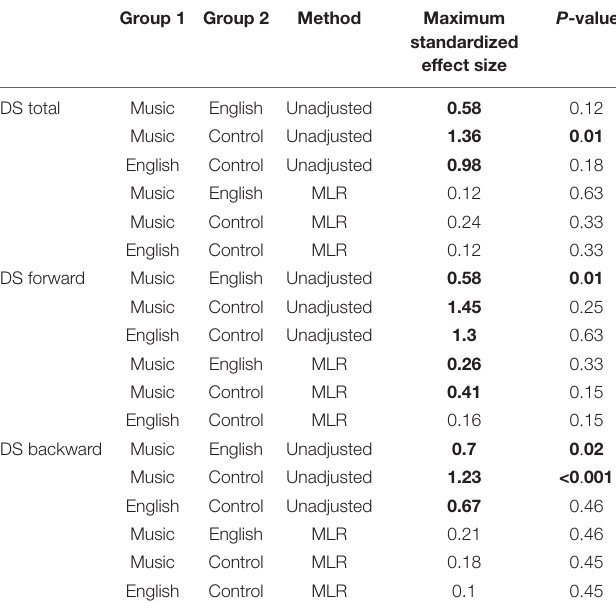
TABLE 2 | Summary of covariate